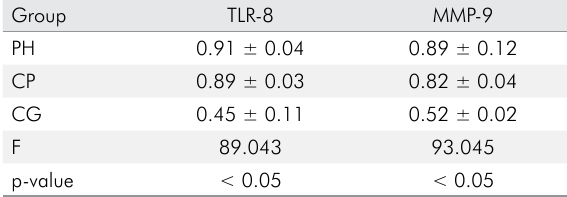
Table 7. TLR-8 and MMP-9 protein expression levels.